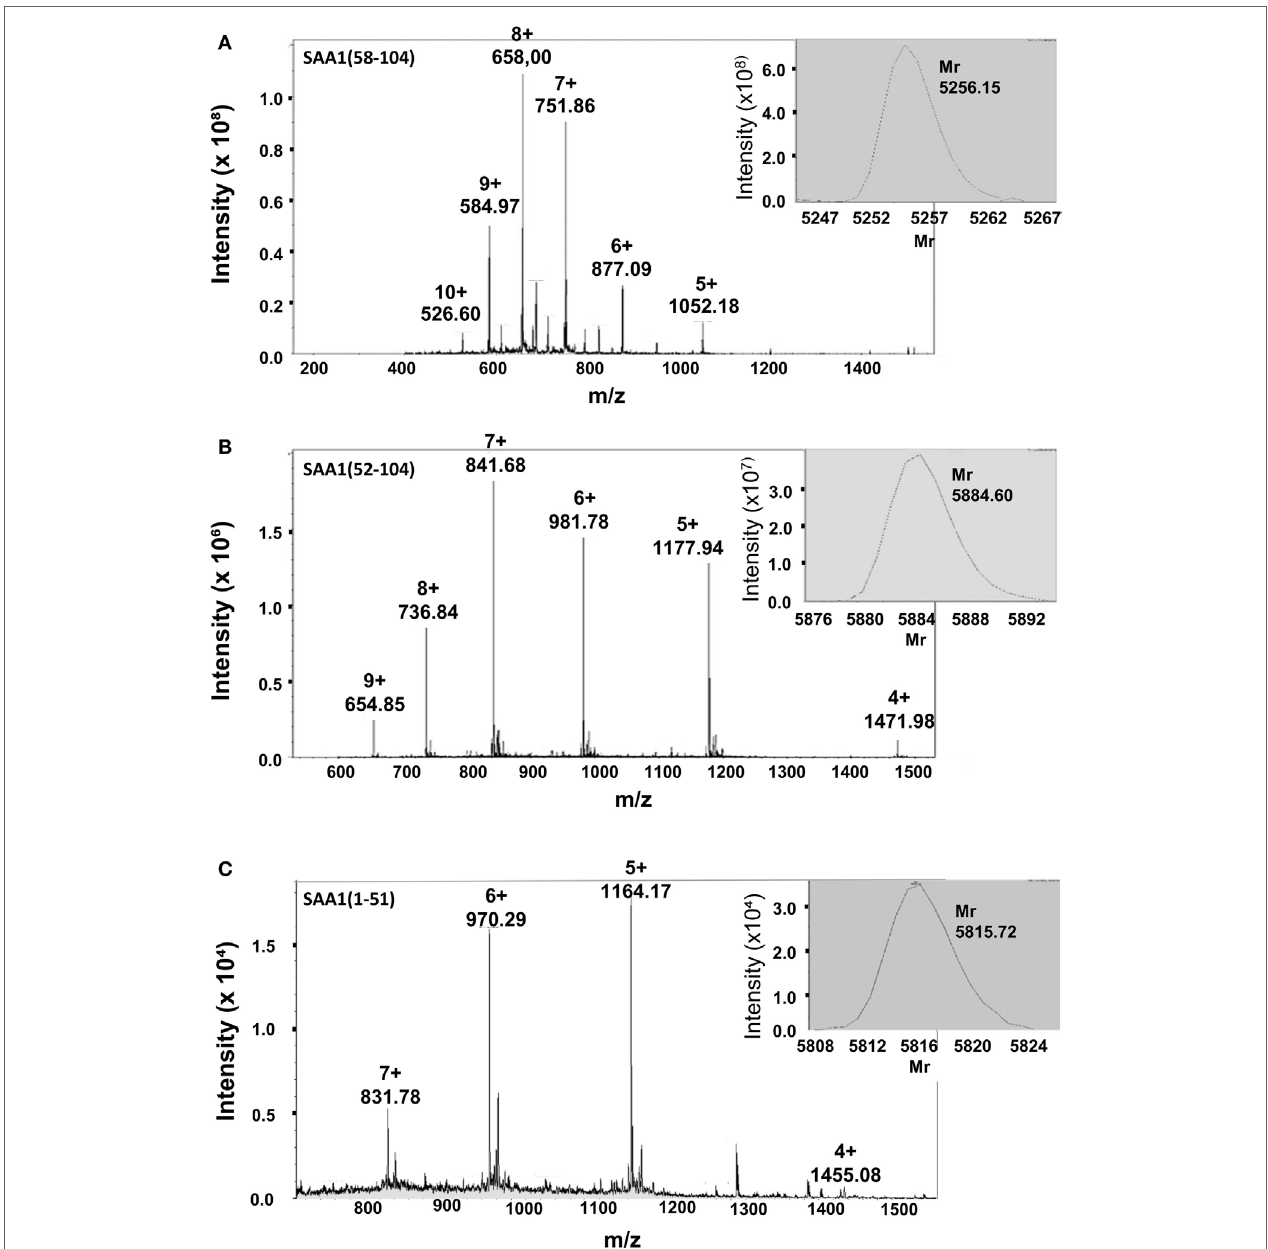
FigUre 3 | Relative molecular mass determination of chemically synthesized, HPLC-purified SAA1(1–51), SAA1(52–104), and SAA1(58–104) by mass spectrometric analysis. The COOH-terminal peptides SAA1(58–104) (a) and SAA1(52–104) (B) and the NH 2 -terminal peptide SAA1(1–51) (c) were chemically synthesized, deprotected, and purified via RP-HPLC. Fractions containing peptides with a correct M r and with sufficient purity were pooled. The averaged mass spectra of these pools are shown with the ion intensities, the number of charges and the corresponding mass over charge ratio ( m / z ) for multiple charged ions. The deconvoluted experimentally determined mass spectra, as calculated by the Bruker deconvolution software, with the M r of the uncharged serum amyloid A1 (SAA1) peptides are shown as inserts at the upper right of the averaged mass